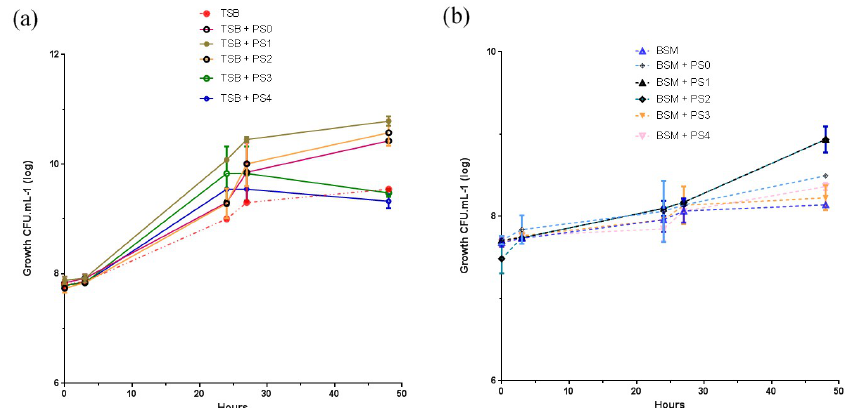
Figure 6. Fermentation of C. necator in growth media; each point is an arithmetic mean of triplicates, while error bars denote the standard error (SE) of the mean for comparison over 48 h. Graph ( a ) shows bacterial growth in TSB with PS0–4 as an additional carbon source and controls ( b ) shows growth in BSM, with PS0–4 as the only carbon source and controls. Table 4. The amount of PHA synthesized by C. necator using 4 g/L PS conducted over a 48 h